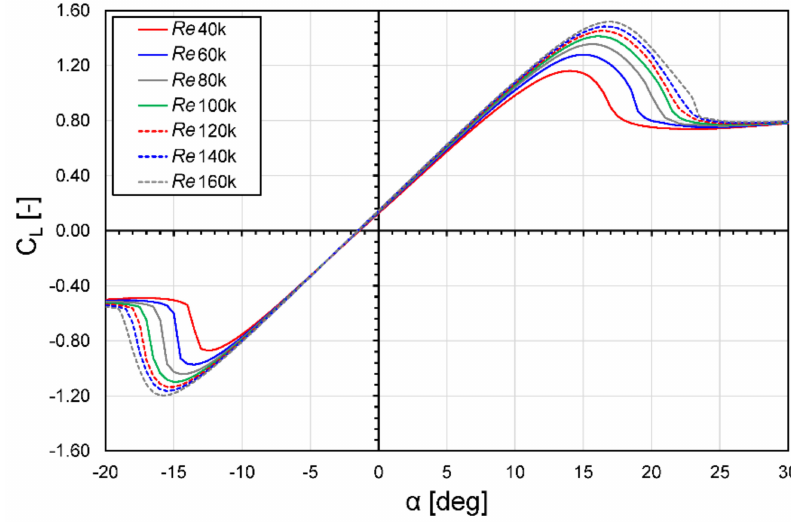
Figure 10. Lift polars for di ff erent Reynolds values with a high turbulence